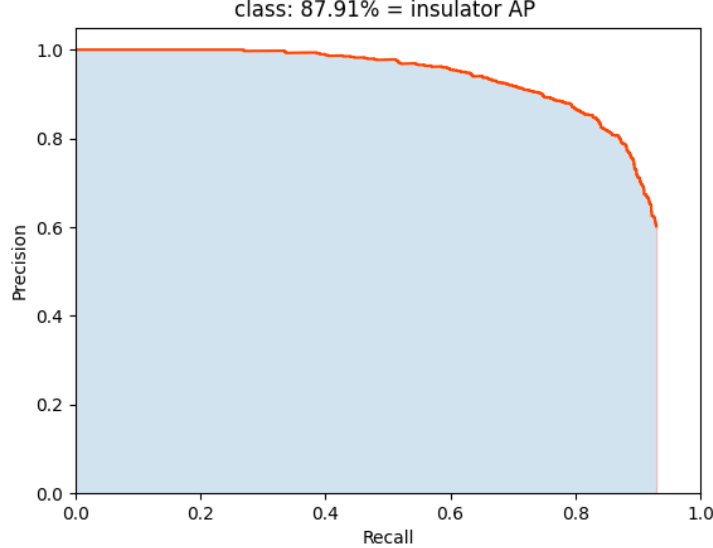
Figure 9. Precision–recall curve graph under the Resnet50 backbone network.